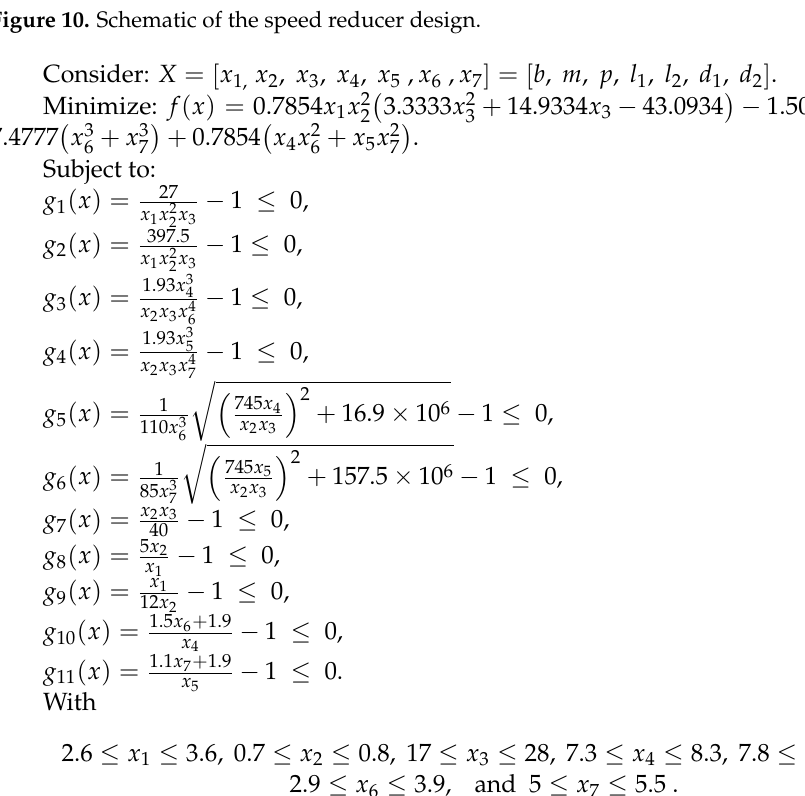
Table 12. Performance of optimization algorithms in the speed reducer design problem.